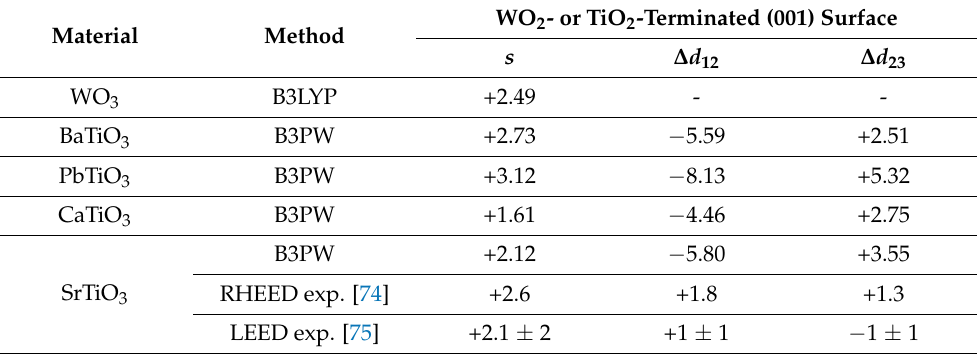
Table 6. Our B3LYP- or B3PW-calculated surface rumplings s and relative displacements ∆ d ij between the three near-surface planes for the WO 2 -terminated WO 3 and the TiO 2 -terminated BaTiO 3 , PbTiO 3 , CaTiO 3 and SrTiO 3 (001) surfaces as a percent of the bulk material lattice constant. The available experimental data are listed for comparison